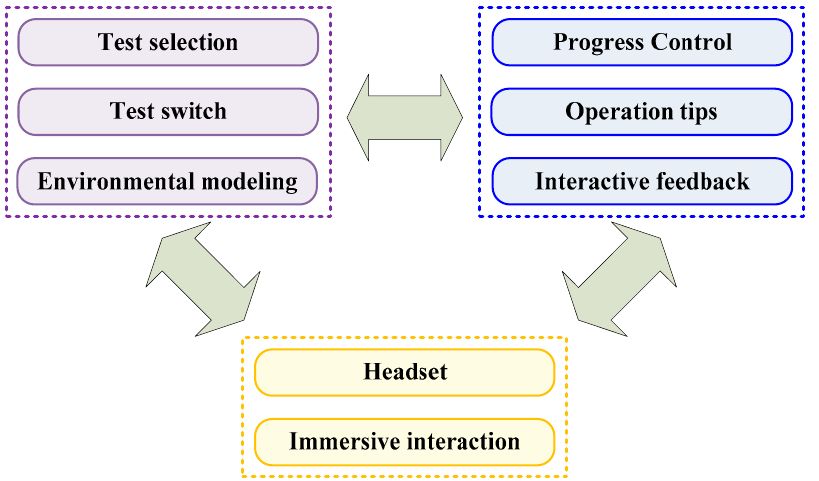
Figure 5. The framework of a VR virtual interactive system.